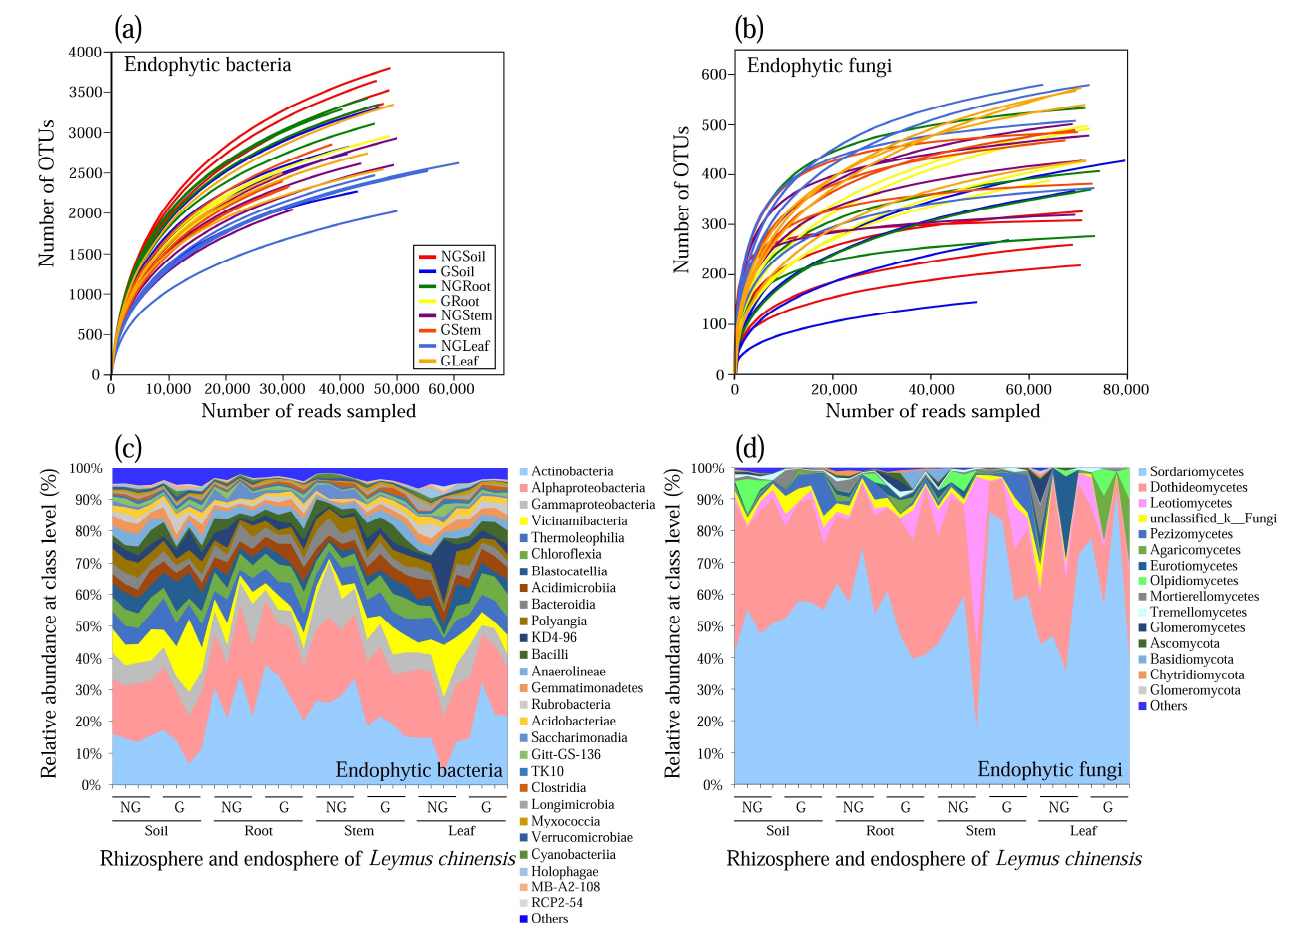
Figure 1. Rarefaction curves of the observed operational taxonomic unit (OTU) number of endophytic bacteria ( a ) and fungi ( b ), and relative abundance of endophytic bacteria ( c ) and fungi ( d ) of Leymus chinensis grown in non-grazed and grazed grasslands. NG: non-grazed grassland; G: grazed grassland.